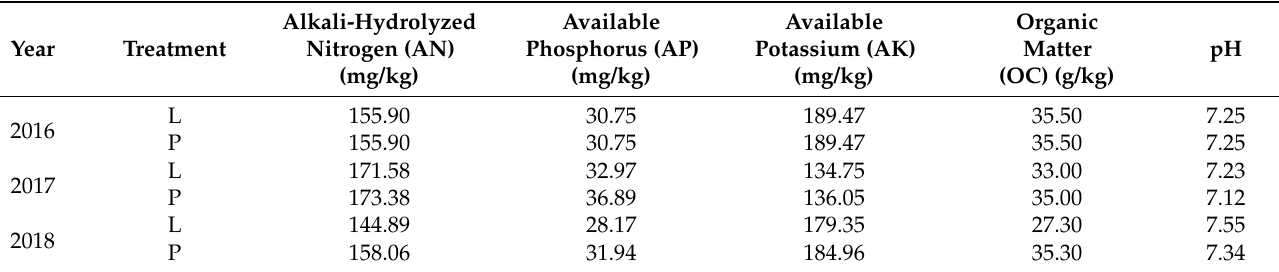
Table 2. Basic physical and chemical properties of the